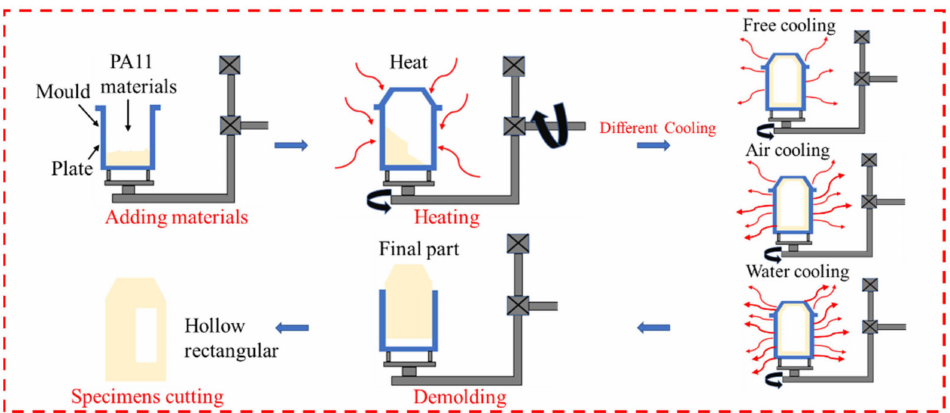
Figure 14. The rotational molding process of different cooling